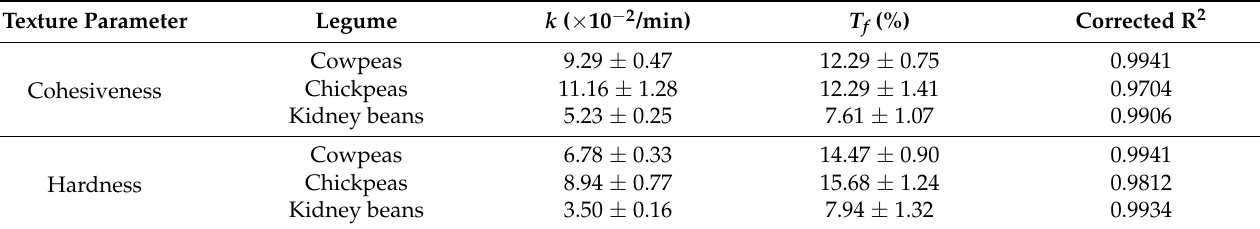
Table 1. Estimated kinetic parameters of legume cohesiveness and hardness as affected by varying durations of hydrother- mal